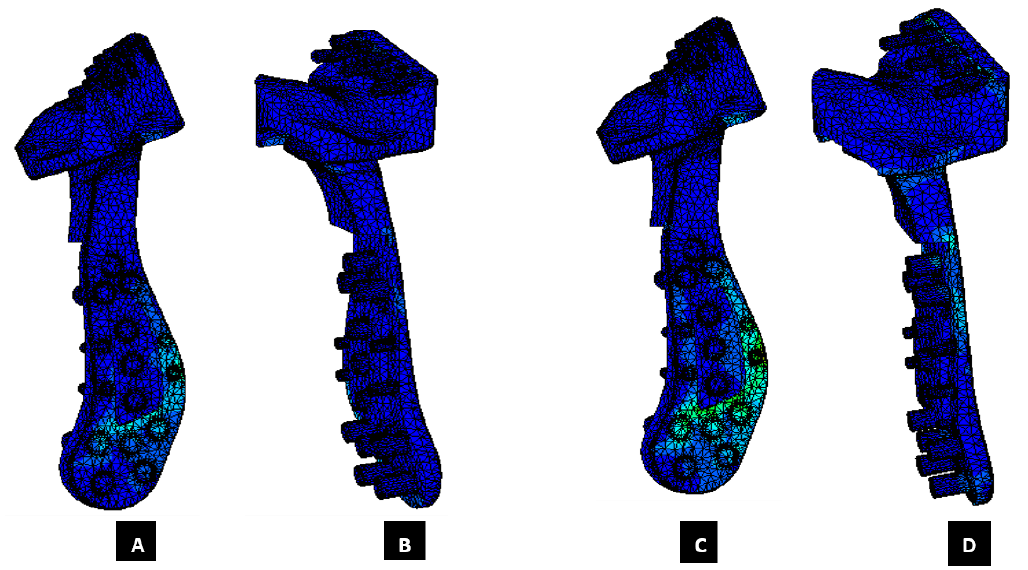
Figure 32. Peak von Mises stress in patient-specific ‘notched’ TMJ prosthesis (with medial notches) during FE simulations of two different loading scenarios. ( A , B ) Show von Mises total TMJ prosthesis under normal loading configuration. ( C , D ) Show von Mises stress profile in the prosthesis during FE simulation of worst-case/over-loading scenario.